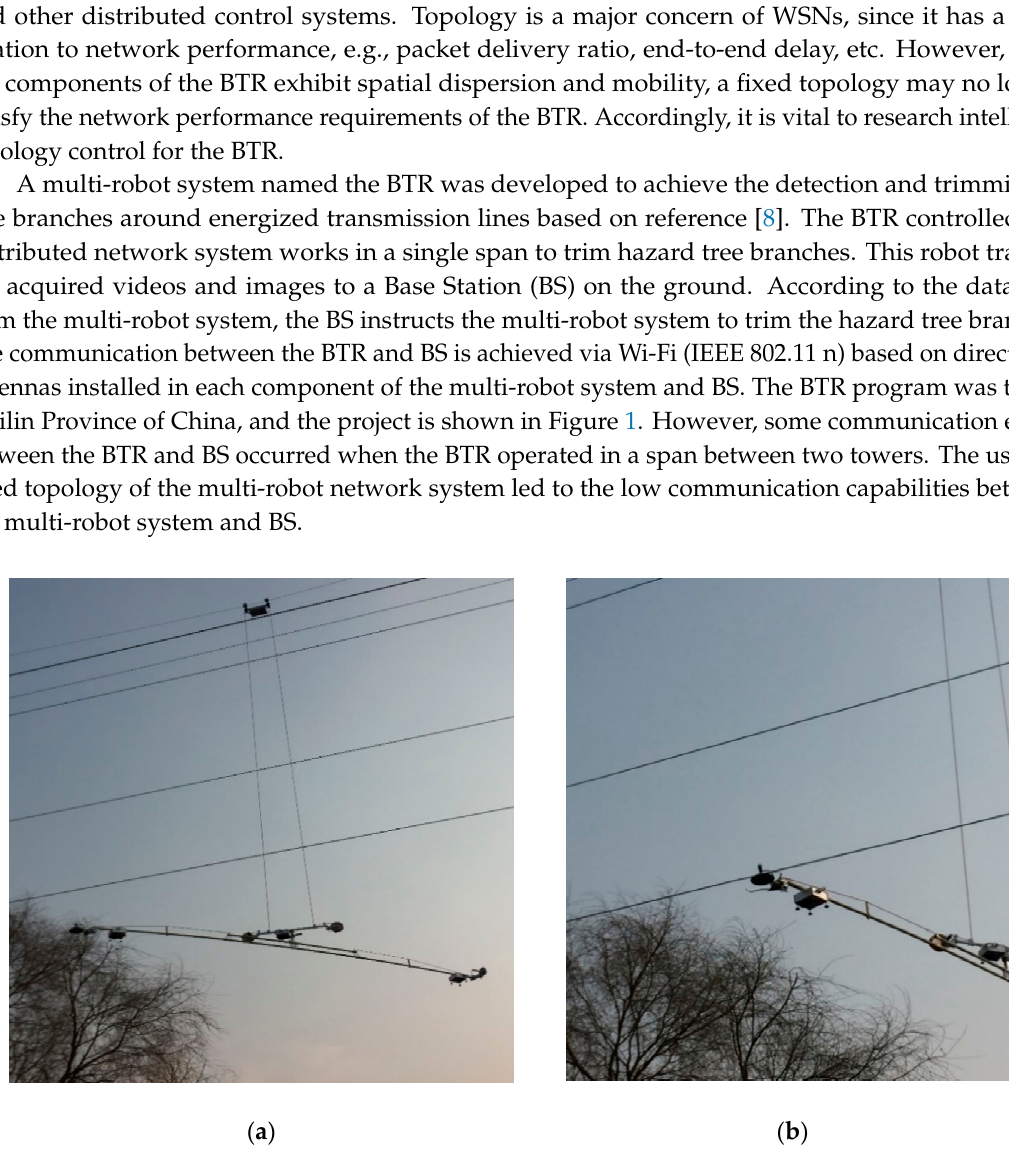
Figure 1. The Branch-Trimming Robot (BTR) program running in Jilin, China. ( a ) Transmission lines, BTR, and hazard trees; ( b ) process of BTR trimming tree